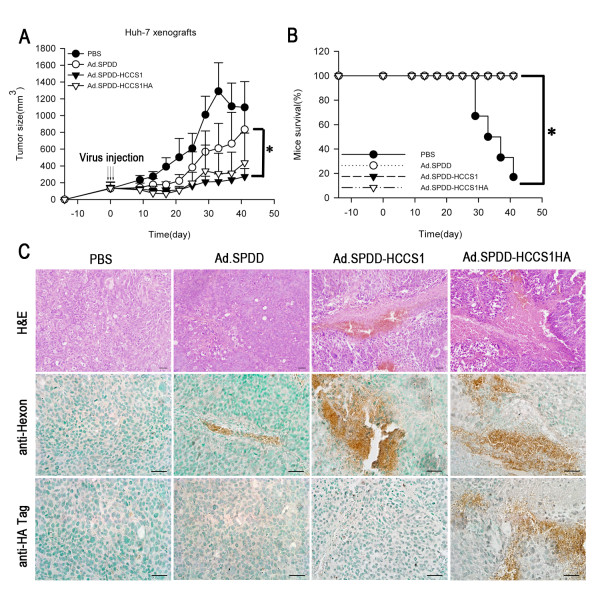
Antitumor efficacy of viruses on Huh-7 tumor xenografts in nude mice. (A) Ad.SPDD-HCCS1 and Ad.SPDD-HCCS1HA suppress the growth of Huh-7 tumors in vivo. The tumor volumes (mean+SD, n = 6) were measured and estimated every four days. (B) The ratios of surviving mice during the observation period in groups treated with different adenoviruses. (C) H&E staining and immunohistochemical staining of tumor sections using anti-hexon and anti-HA tag antibodies. Representative images are shown at 400 × magnification for the different samples Scale bar = 100 μm. (*: P < 0.05).